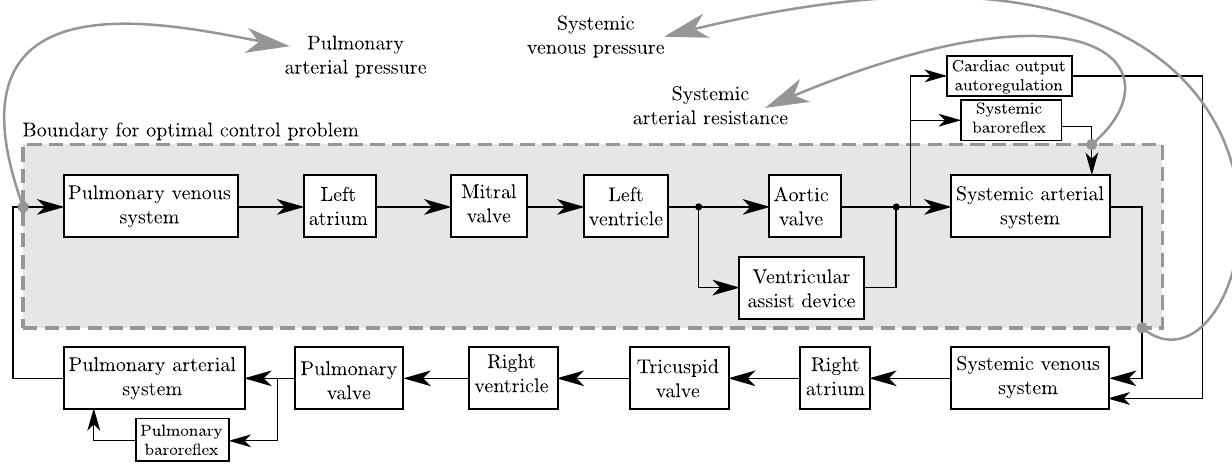
Figure 1. The subsystems of the numerical circulation model described in [24,25], including a ventricular assist device. The optimal-control problem (OCP) considered in the current paper is based on the reduced model indicated by the gray box. There are three boundary conditions that were computed by the full model: the pulmonary arterial pressure, the systemic venous pressure and the systemic arterial resistance. The latter is influenced by the baroreflex mechanism. These quantities do not change, as long as the total cardiac output and, thus, the mean arterial pressure are